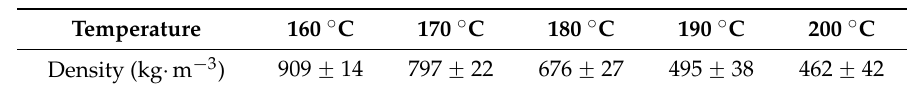
Figure 12. Microspheres TMA and epoxy system gel time analysis: correlation of results. Table 2. Density of foam samples.